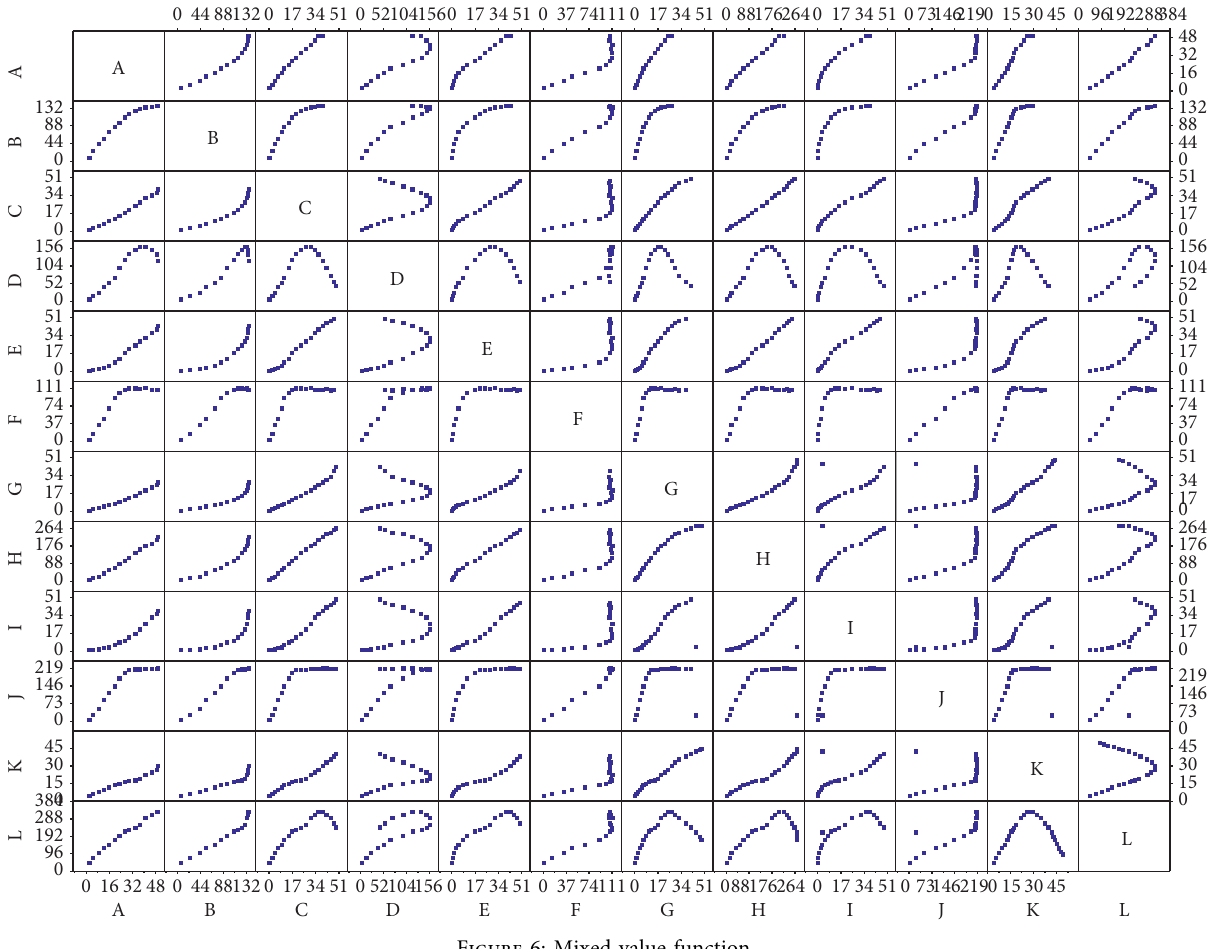
Figure 6: Mixed value